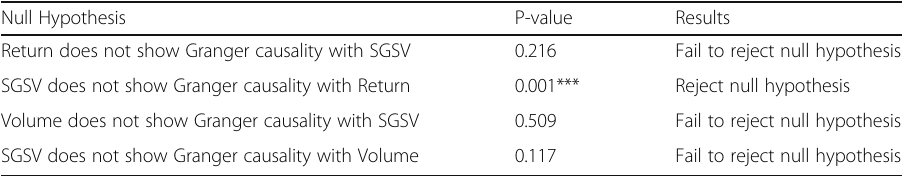
Table 4 Granger Causality